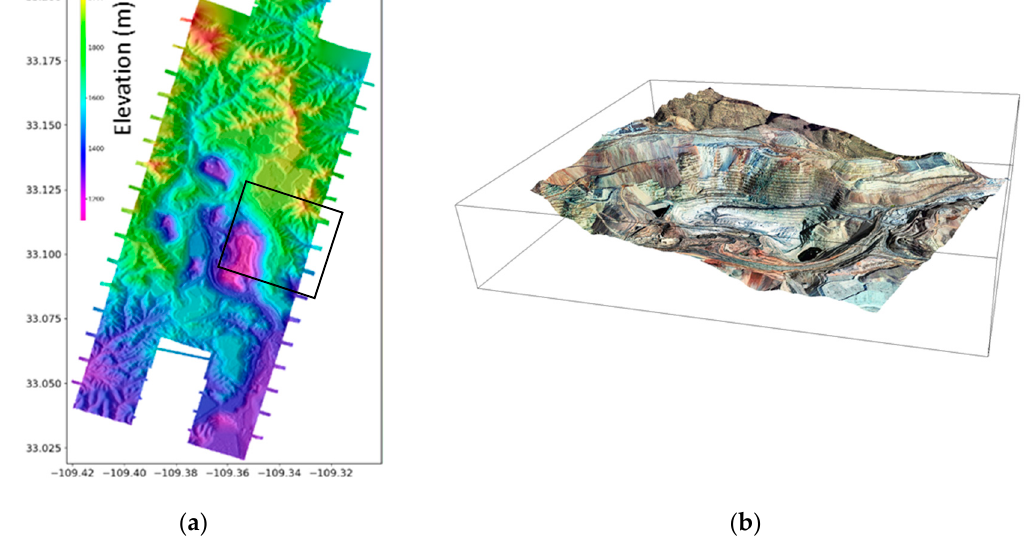
Figure 7. ( a ) DEM of Morenci Mine are computed in the object space from tri-stereo SkySat on 1 January 2019; ( b ) a zoom view of 3D-textured model (a flyover animation of the 3D model is available in the Supplementary Materials).